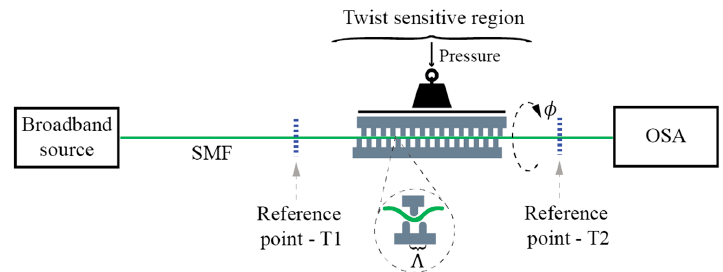
Figure 8. Mechanically induced LPFBG (M-LPFBG) twist/torsion test setup.